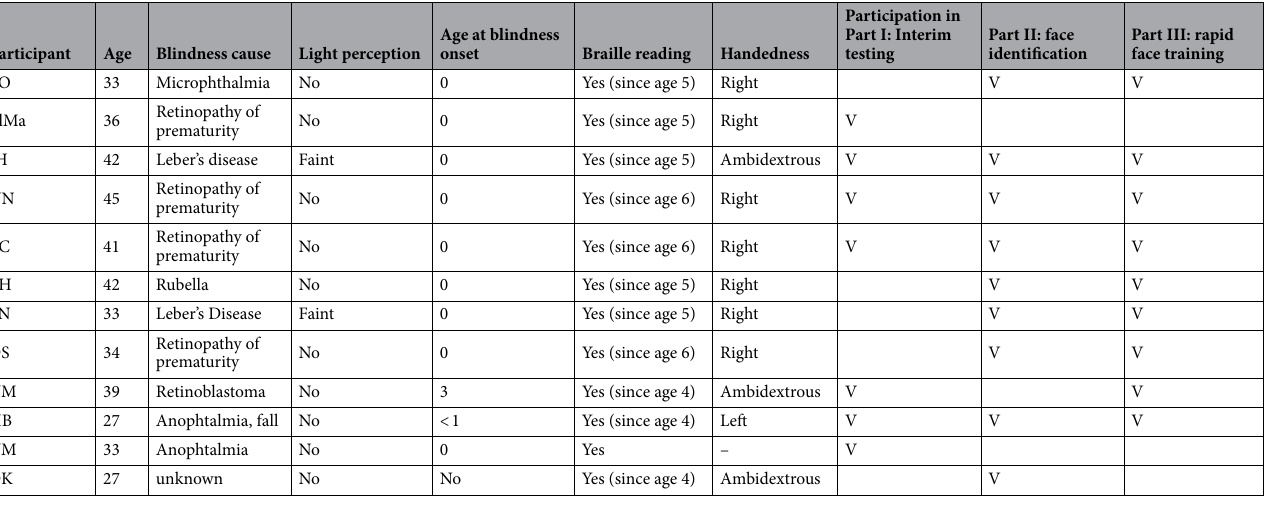
Table 1. Demographic details of